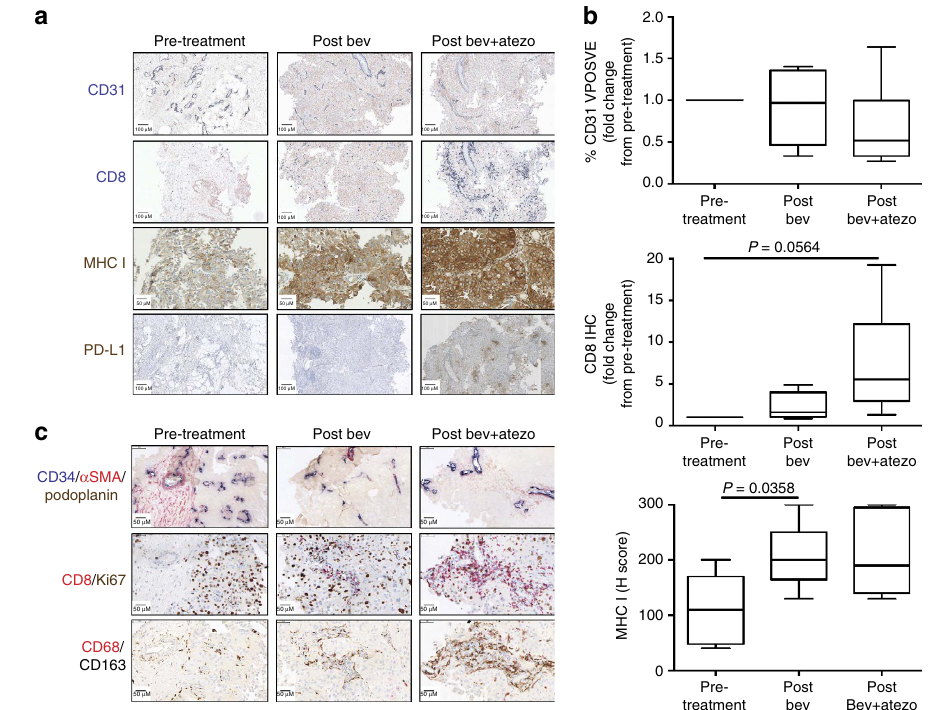
Figure 3 | Protein expression of immune and vasculature markers in baseline and on-treatment tumour samples. ( a ) Representative images of CD8 (blue), CD31 (blue), PD-L1 (brown) and MHC-I (brown) by IHC from patient 3 tumours. ( b ) Quantitation of CD31, CD8 and MHC-I IHC. P values were determined by paired t -test. The line in the middle of the box is plotted at the median. Lines above and below the boxes represent variability outside the upper and lower quartiles. ( c ) IHC images for the indicated triple and double stains of serial sections from patient 3 tumours. A scale bar for each image representing 50 or 100 m m is shown. atezo, atezolizumab; bev,